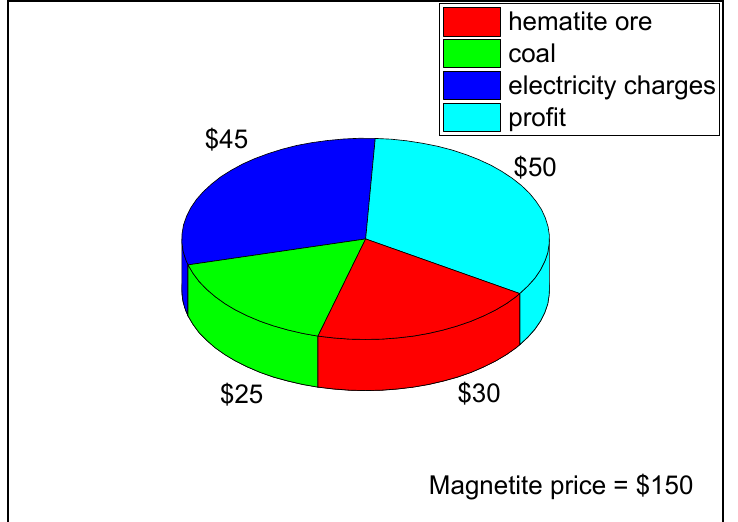
Figure 13. Cost distribution of magnetite in comparison to the whole process.